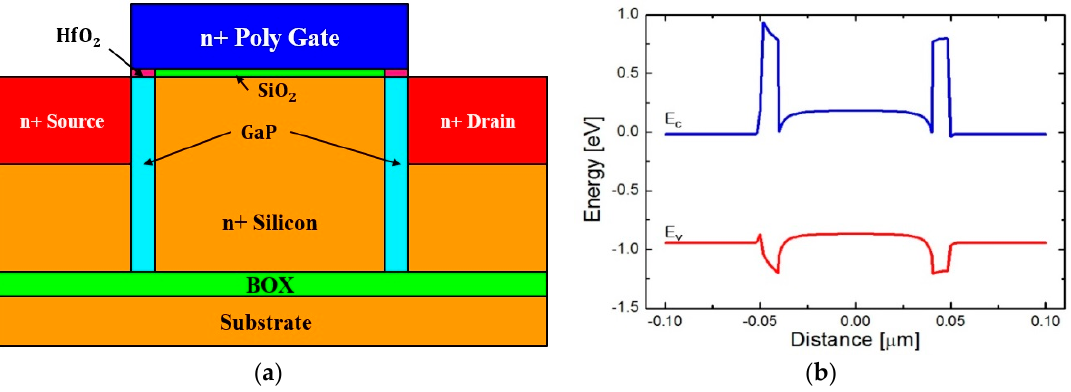
Figure 1. Device structure. ( a ) Schematic of the one-transistor dynamic random-access memory (1T DRAM) with partially introduced wide-bandgap barriers; ( b ) energy-band diagram along the channel direction in the proposed device.